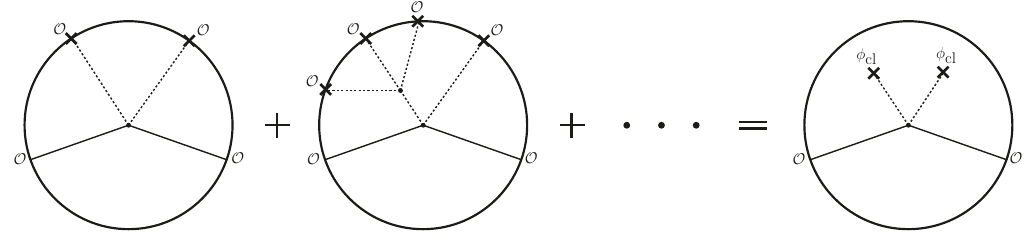
Figure 10 . The higher-point function contributions to H e(cid:11) corresponding to AdS \plant diagrams" resum to reproduce the bulk pro(cid:12)le (cid:30) cl which solves the bulk equations of